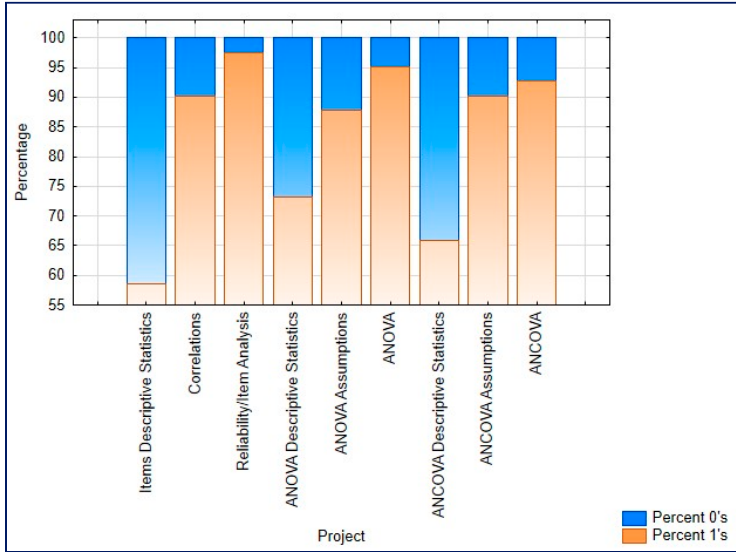
Figure 8. Stacked graph—visualization of success in particular tasks.